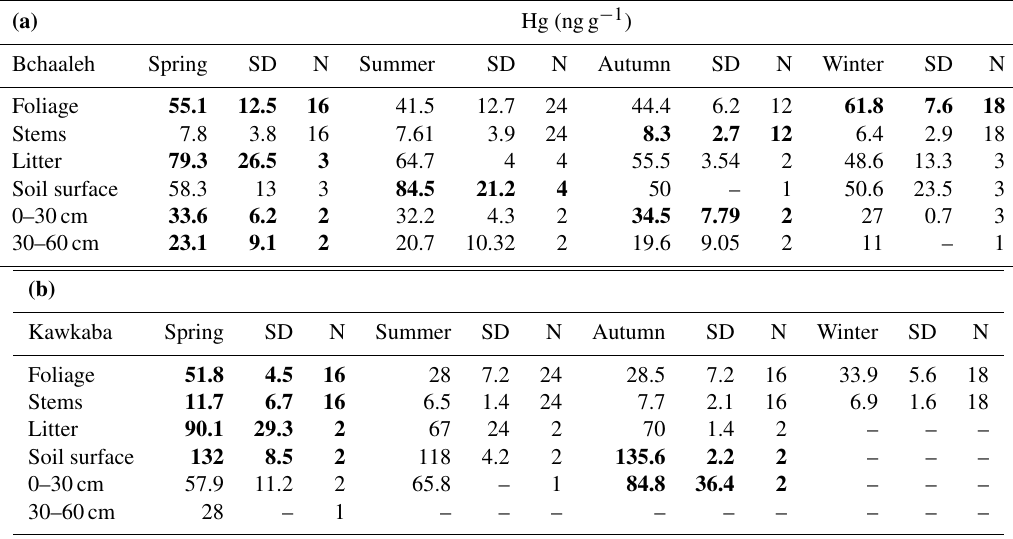
Table 2. Seasonal mean Hg concentration (ngg − 1 ) and standard deviations of the different studied materials in both Bchaaleh and Kawkaba olive groves. Bold formatting indicates the highest Hg concentration values among the different materials during the different seasons.